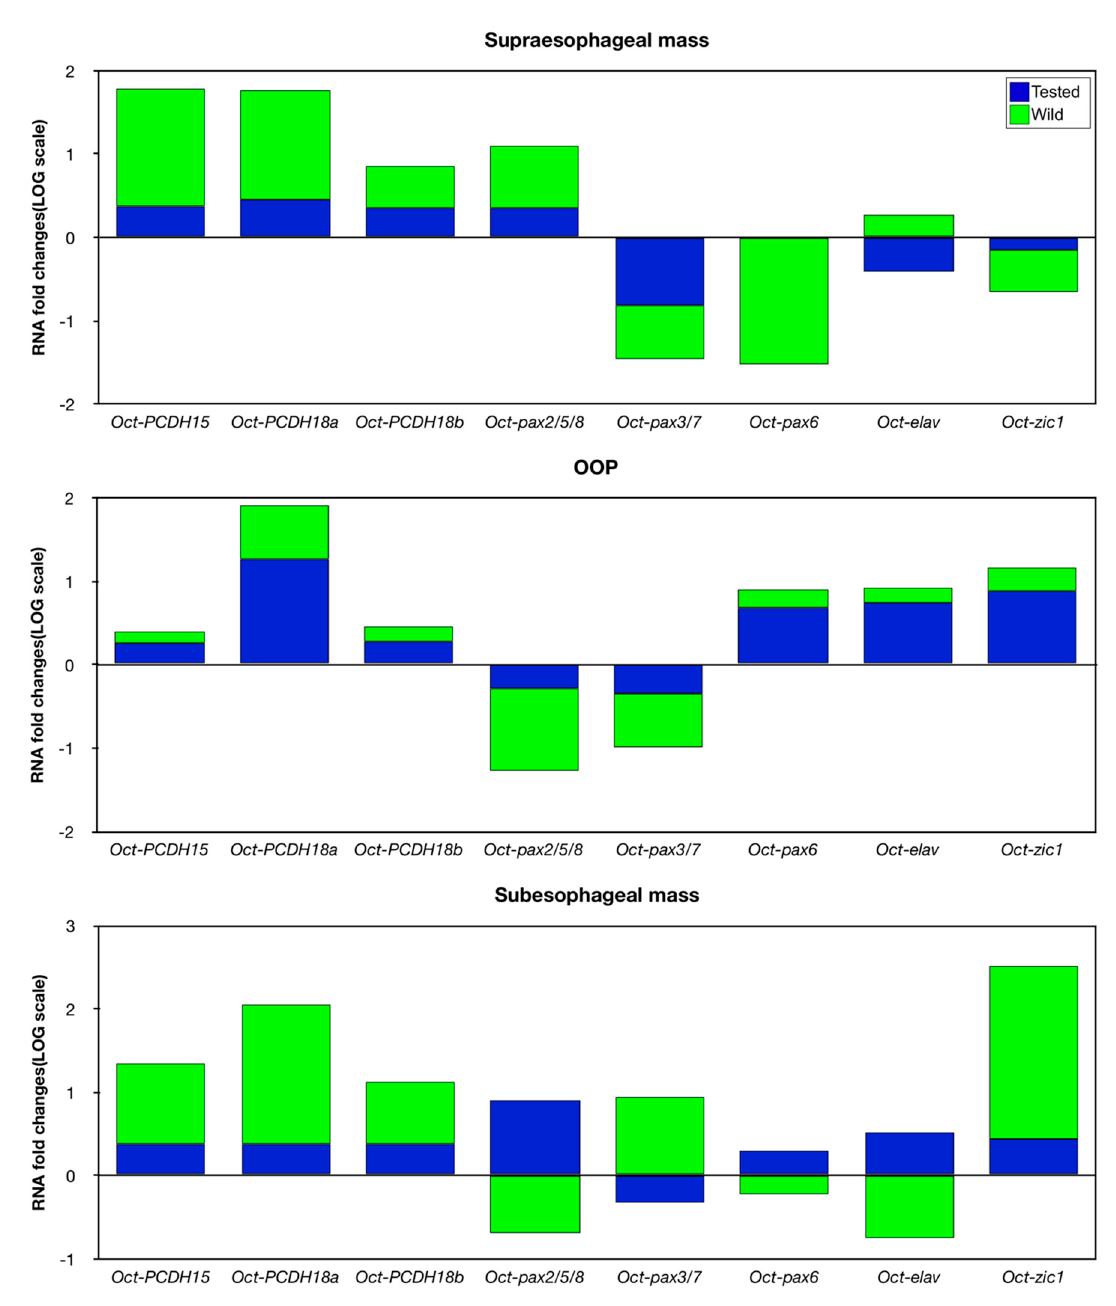
Figure 6. Map of gene expression detected in supraesophageal mass, OOP, and subesophageal mass in Octopus vulgaris under different degree of cognitive stimulation. Relative mRNA fold change in gene expression was, in the logarithmic scale, tested and wild octopuses were compared to control (N = 6/group; line set y = 1).